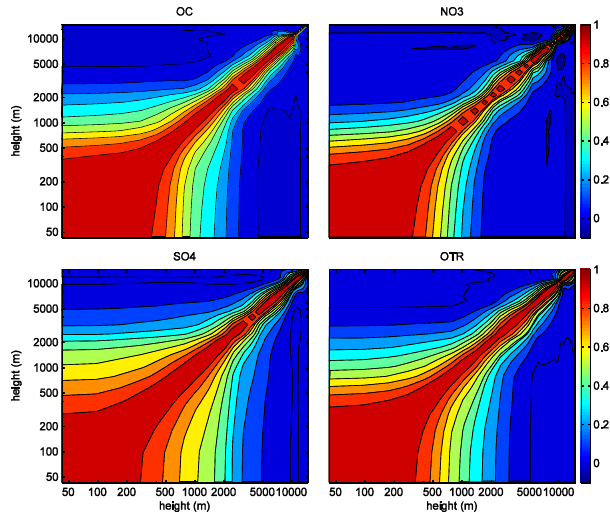
− , , , and OTR. Fig. 4. Vertical correlations of the background errors for EC, NO 3 NO SO